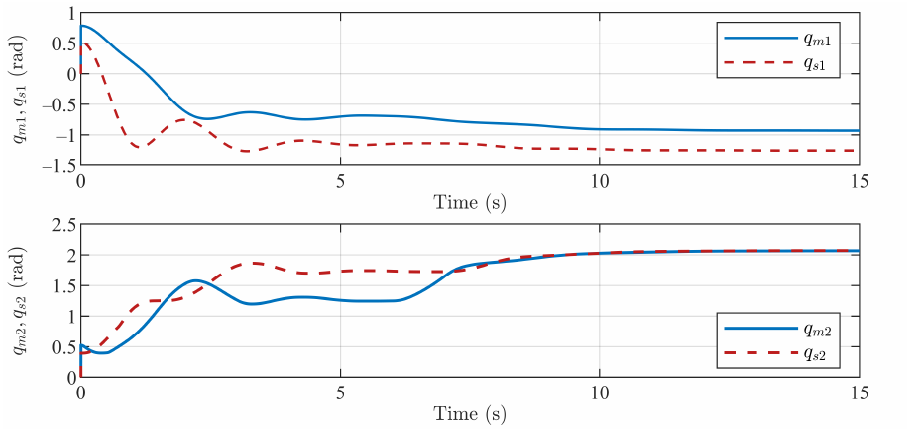
Figure 14. Joint positions with the method in Case